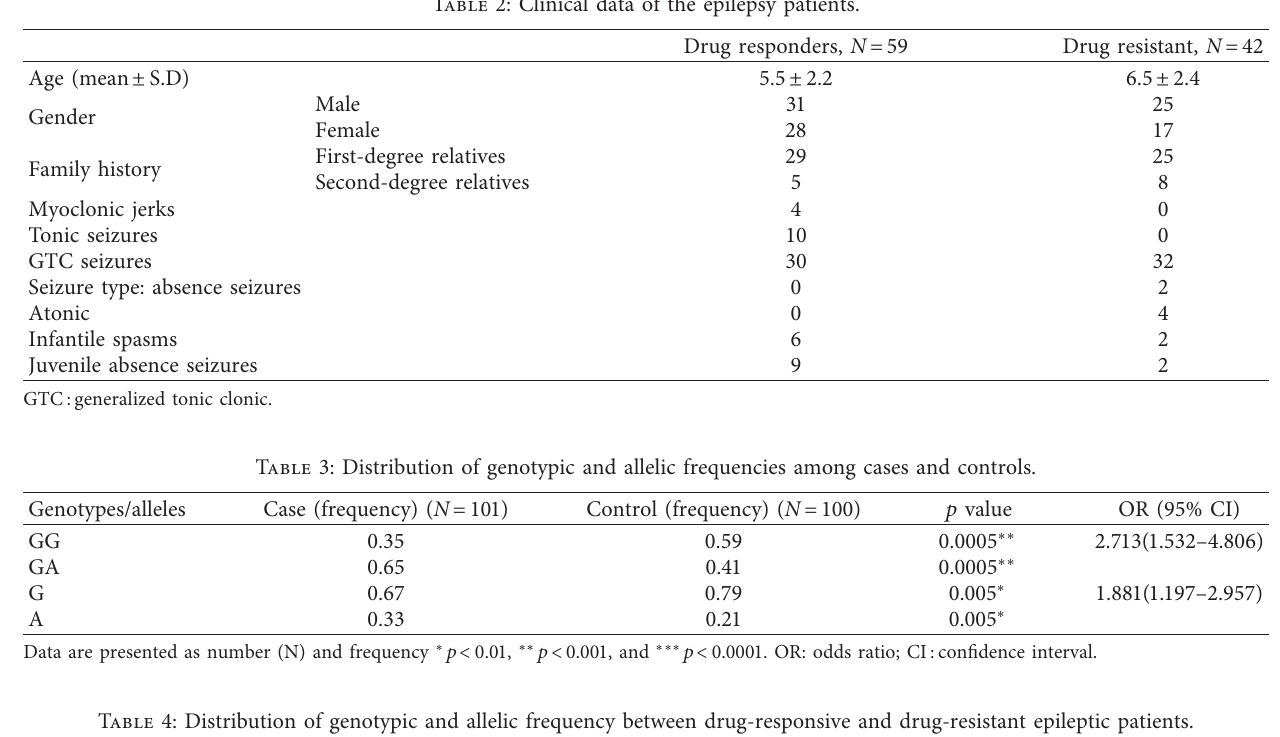
Table 4: Distribution of genotypic and allelic frequency between drug-responsive and drug-resistant epileptic patients.